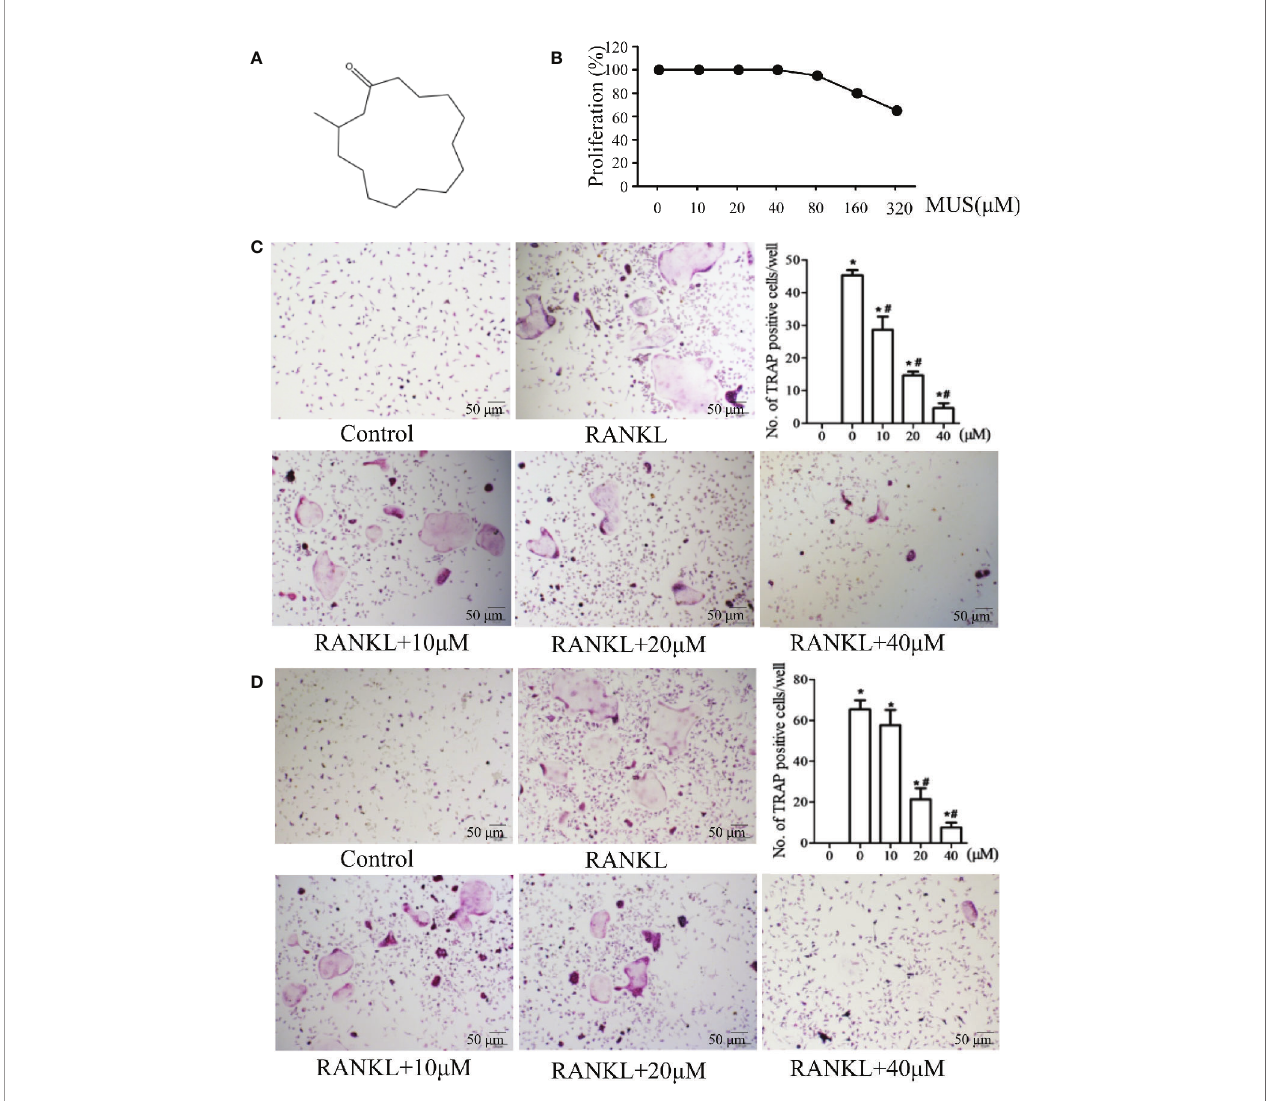
FIGURE 1 | Muscone inhibits osteoclastogenesis in BMMs and the RAW264 cell line. (A) Chemical structure of muscone. (B) proliferation of muscone-exposed BMMs. (C, D) BMMs and RAW264.7 cells are used and treated with 10, 20, 40 m M muscone, and TRAP-positive cells are quanti fi ed (magni fi cation ×100). *P < 0.05 vs. the control group, # P < 0.05 vs. the RANKL-induced